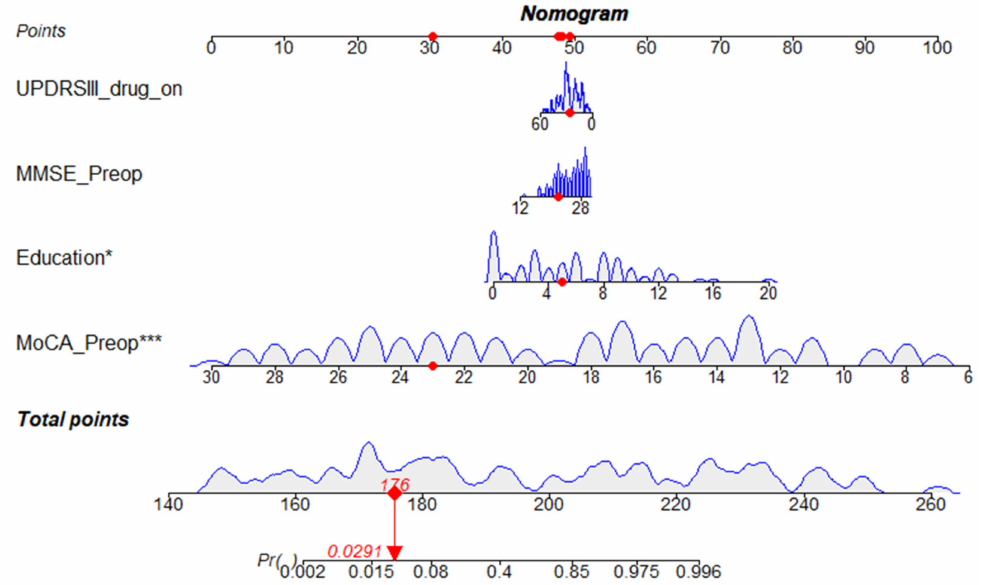
Figure 4. Nomogram to predict improvement of MoCA score after STN-DBS for PD. Clinical factor corresponds to a specific point by drawing a line straight upward to the points axis. After the sum of the points is located on the total points axis, the sum represents the probability of obtaining higher a MoCA score improvement rate. * p < 0.01, *** p < 0.001.